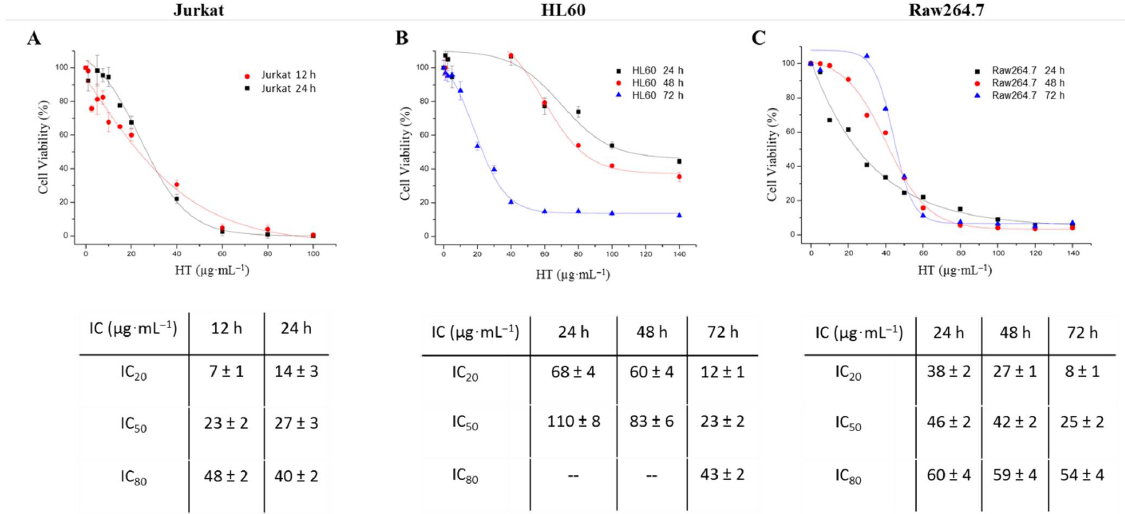
Figure 2. Cytotoxicity curves of hydroxytyrosol during 12 and 24 h in Jurkat cells ( A ); 12, 48 and 72 h in HL60 ( B ) and Raw264.7 at the same three times ( C ). The assays were performed using three independent populations of cells. Results expressed as µ g · mL − 1 are mean ± SEM. IC 80 , IC 50 and IC 20 values for the Jurkat, HL60 and Raw264.7 lines after 12, 24, 48 and 72 h of incubation with hydroxytyrosol and are indicated in the tables below the graph. These results were obtained by a dose–response model using OriginPro 8 software (OriginLab ® , Northampton, MA, USA). IC, inhibitory